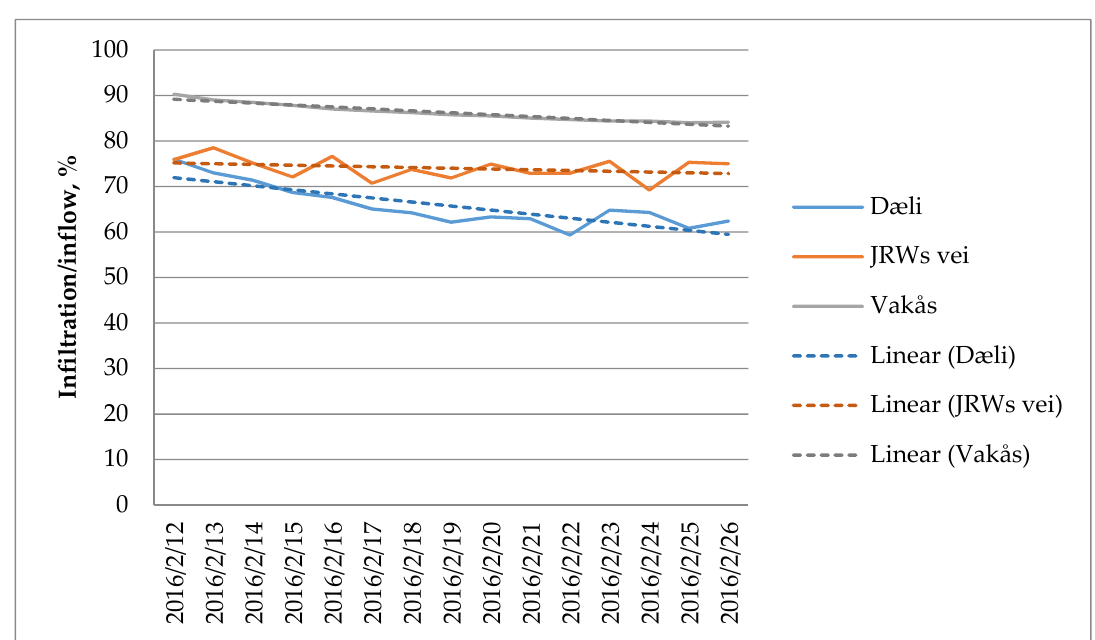
Figure 5. Calculated share of I/I-water in a dry weather period, before the implementation of the measures.